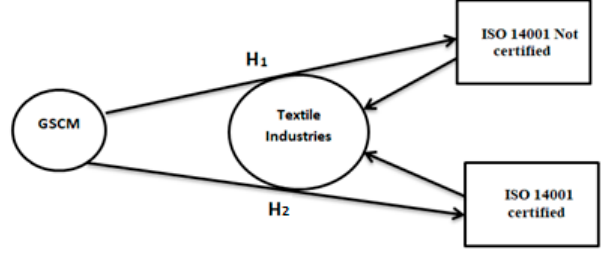
Figure 4. Proposed hypothesis model.